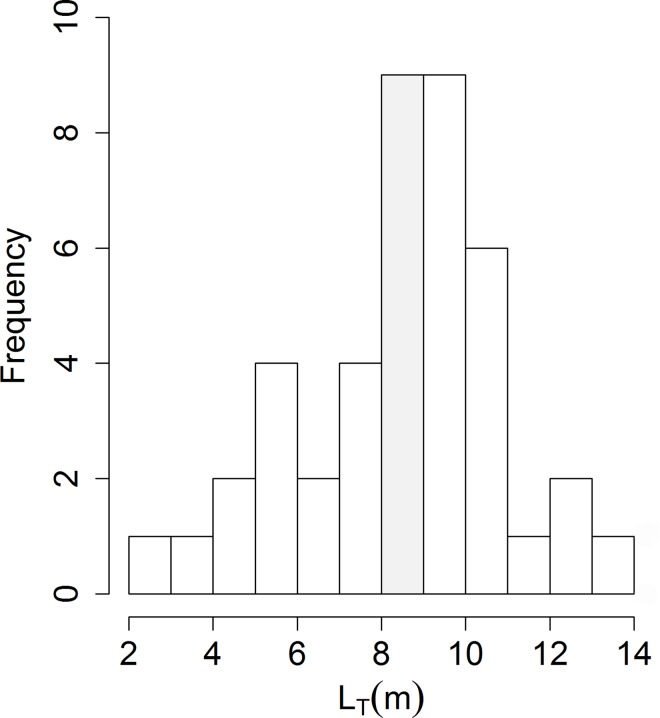
Length frequency of whale sharks.Absolute frequency of R. typus LT (m) in the ASPSP. Immature (left) and mature (right) are separated by the shaded area of transitional size animals.